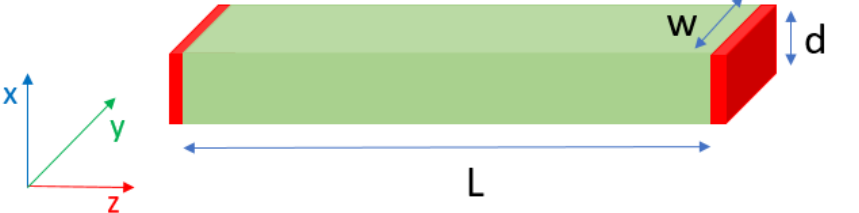
Figure 10. Sketch of the device as a plane parallel plate capacitor (in red) filled with a material (GRMs) with dielectric constant 𝜖 (cid:3045) (in green).